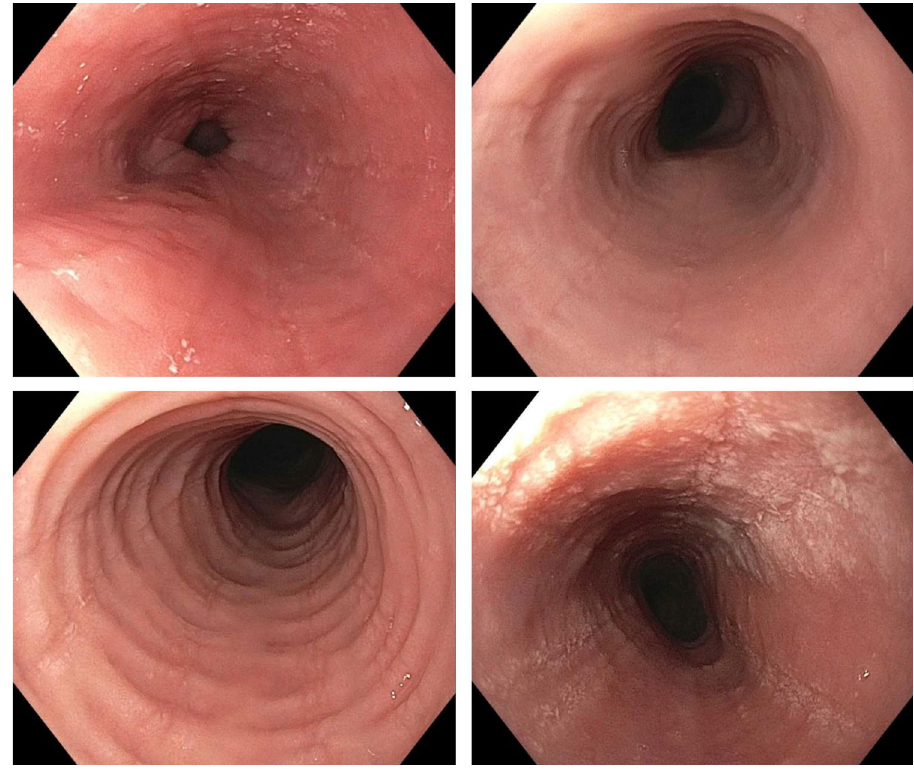
Figure 1. Endoscopic white light images of eosinophilic esophagitis showing furrows, exudates, edema, and